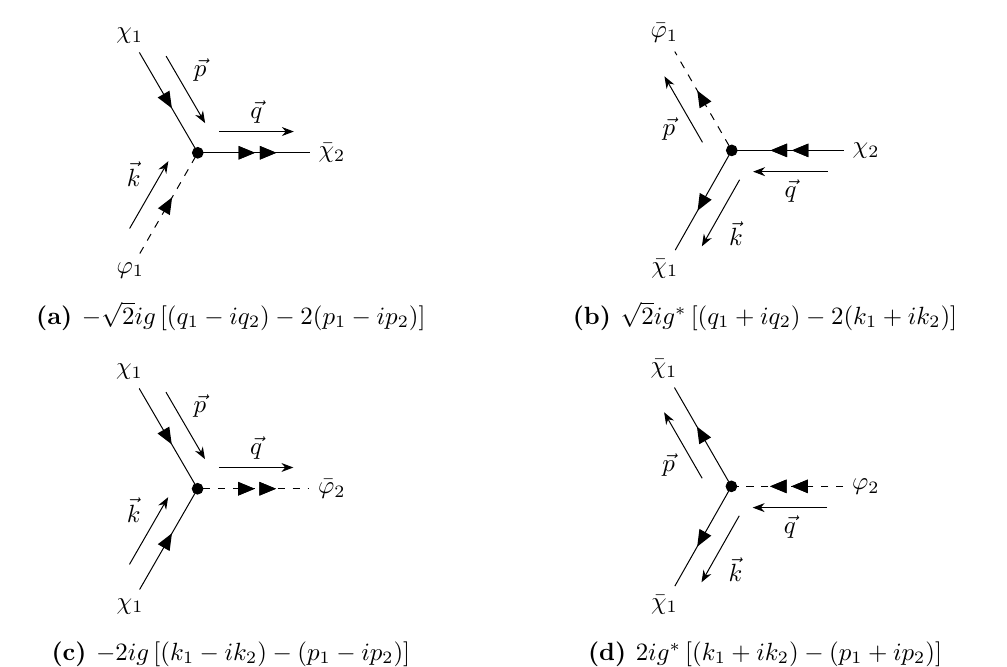
Figure 14. Feynman rules for three-point vertices. Scalars are denoted by dashed lines, while fermions by continuous